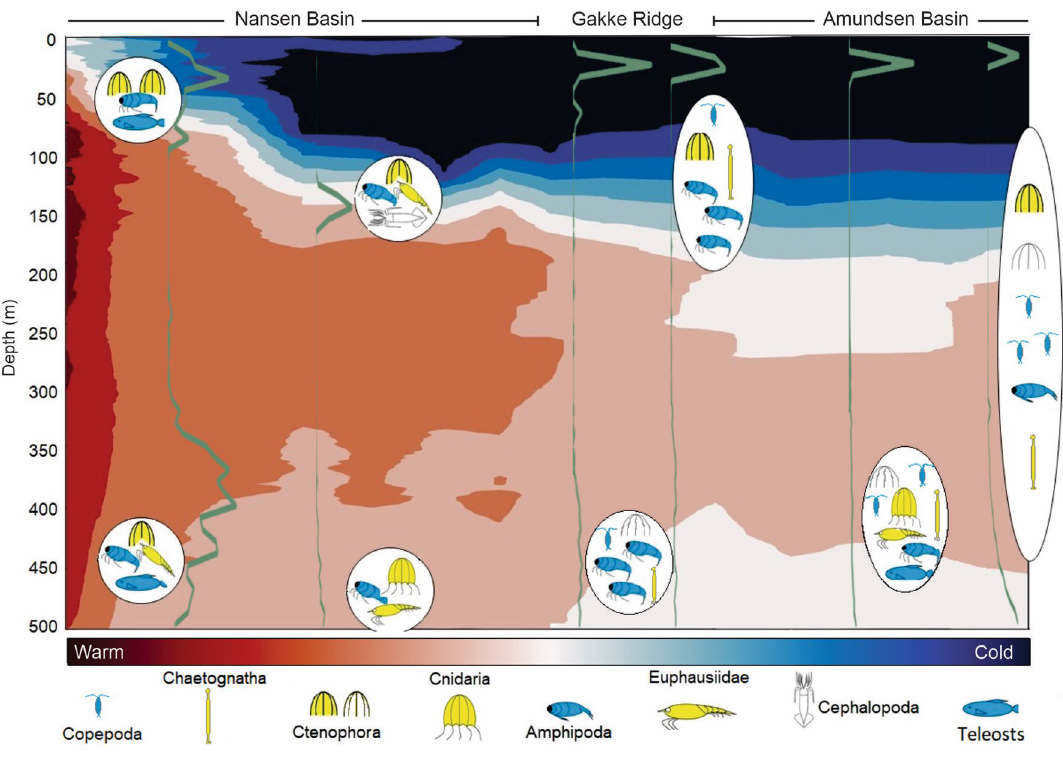
Figure 5. Schematics of dominant epi- and mesopelagic fauna along the Eurasian Basin transect based on trawl catches. Arctic organisms are shown in blue colour and subarctic-boreal ones in yellow. Symbols for organisms defined to higher taxa level (which could include species belonging to different bio-geographic affinity) are shown in white. Bubbles with organisms are place at approximate range of sampling depth. Note that absence of smaller organisms like copepods and chaetognaths in the Nansen Basin is due to sampling bias, as the macroplankton trawl was not used there. The green lines show backscatter strength while the background colour is the temperature field from Fig.